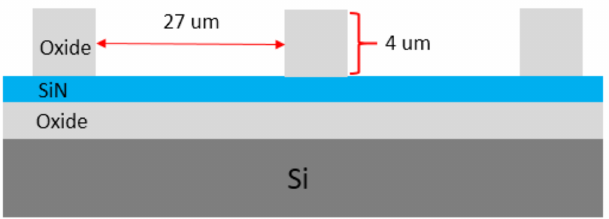
Figure 1. The target structure for film stacking of the passivation layer in a memory device.